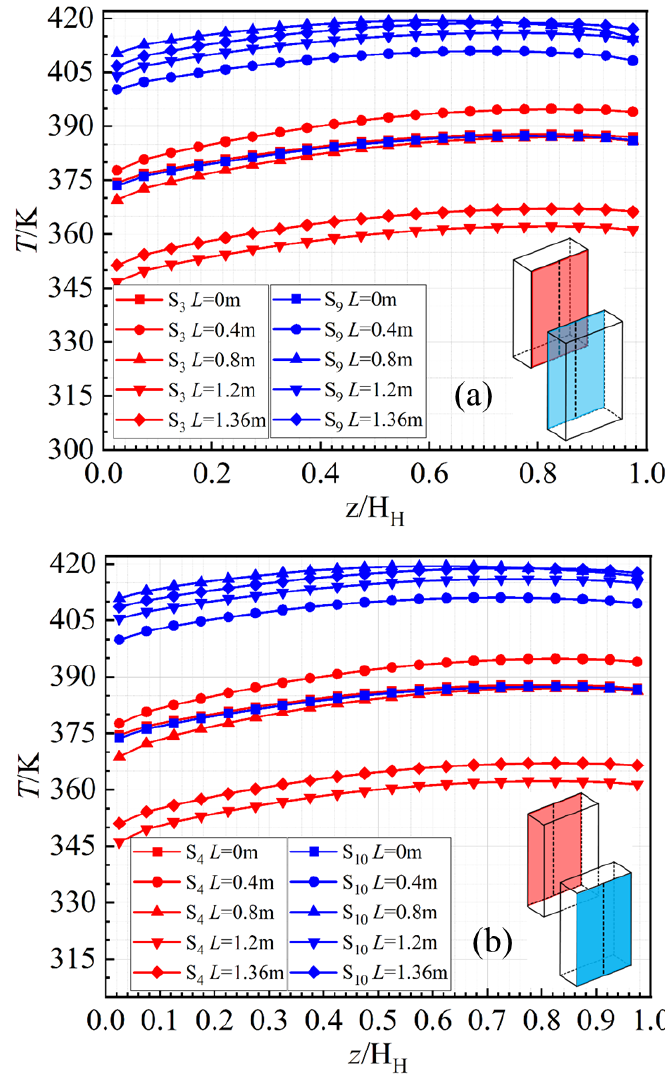
Figure 9. The local temperature distributions of the side walls of the heat sources with different L . ( a ) S 3 and S 9 . ( b ) S 4 and S 10 .